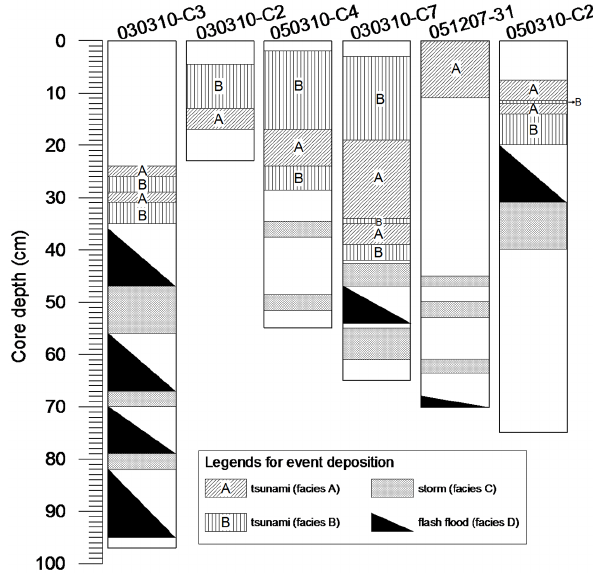
Figure 5. Event sequence log diagram for sediment cores taken in shallow water (<15m water